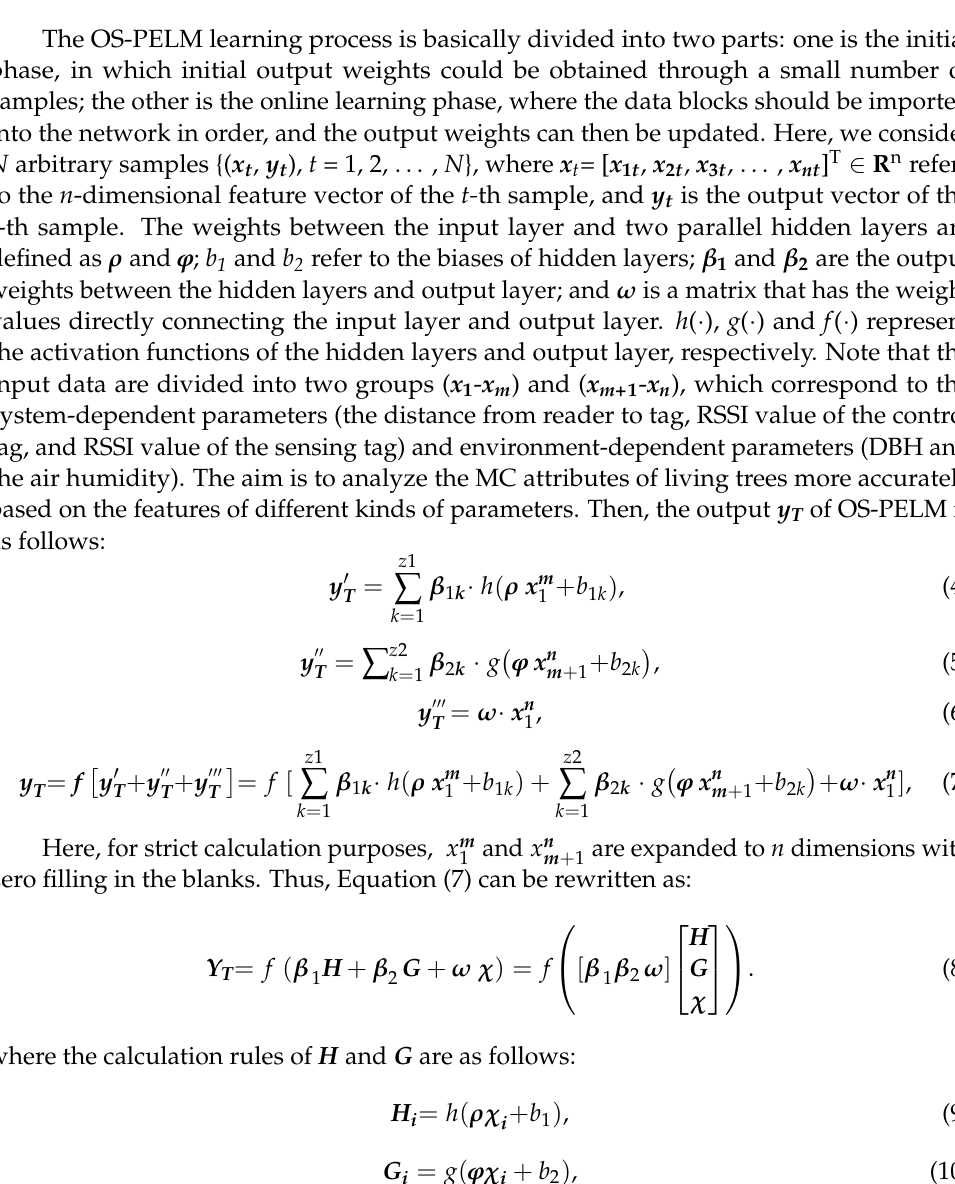
Figure 6. The OS-PELM structure. A strategy of multiple hidden layers is adopted to optimize the network structure.